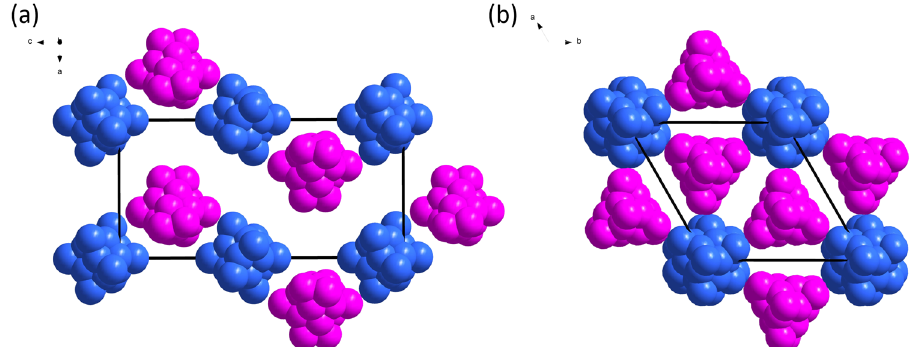
Fig. 6 Illustration of packing diagrams of the co-crystallized NCs 3a and 3b with dsep ligands omitted for clarity. a View down the b axis. b View down the c axis (color code: T layers are in blue and C 3 layers in